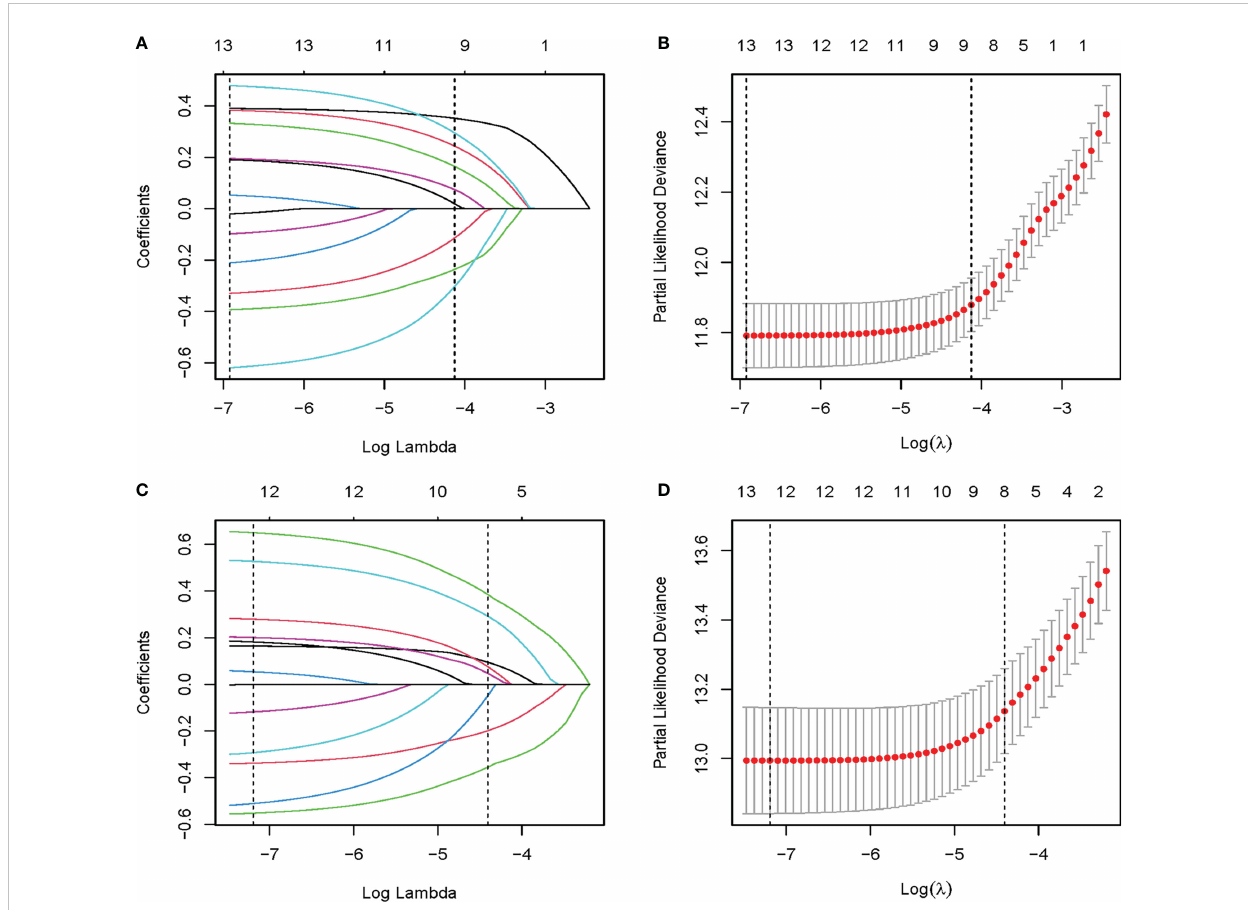
FIGURE 2 The LASSO regression used to select prognostic factors. (A) LASSO coef fi cient pro fi les of 13 variables for OS; (B) LASSO Cox analysis identi fi ed 9 variables for OS; (C) LASSO coef fi cient pro fi les of 13 variables for BCSS; (D) LASSO Cox analysis identi fi ed 8 variables for BCSS. OS, overall survival; BCSS, breast cancer-speci fi c survival; LASSO, the least absolute shrinkage and selection